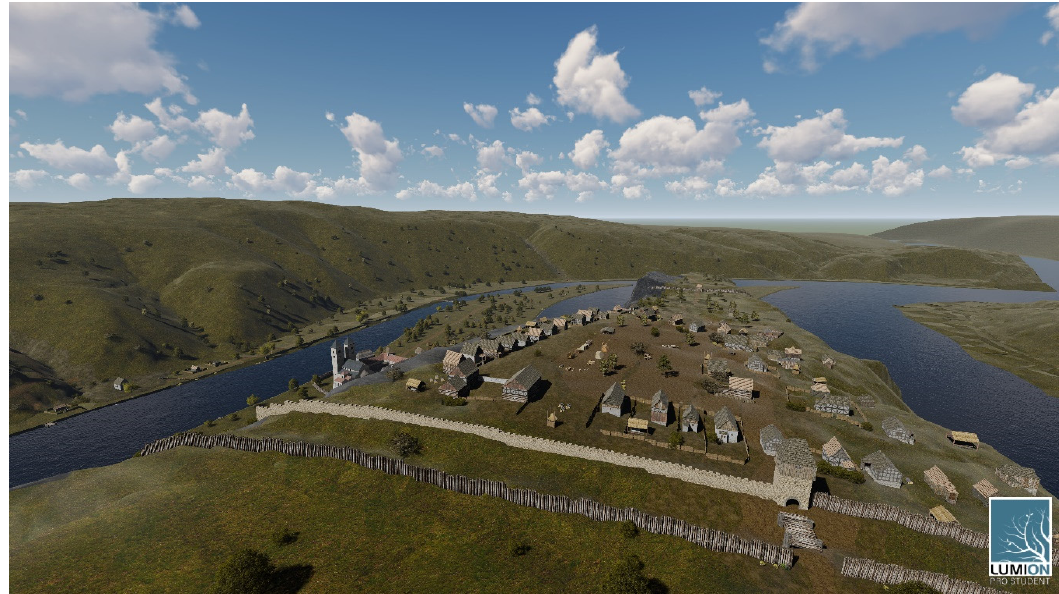
Figure 8. Visualization of the reconstructed middle age town Sekanka.